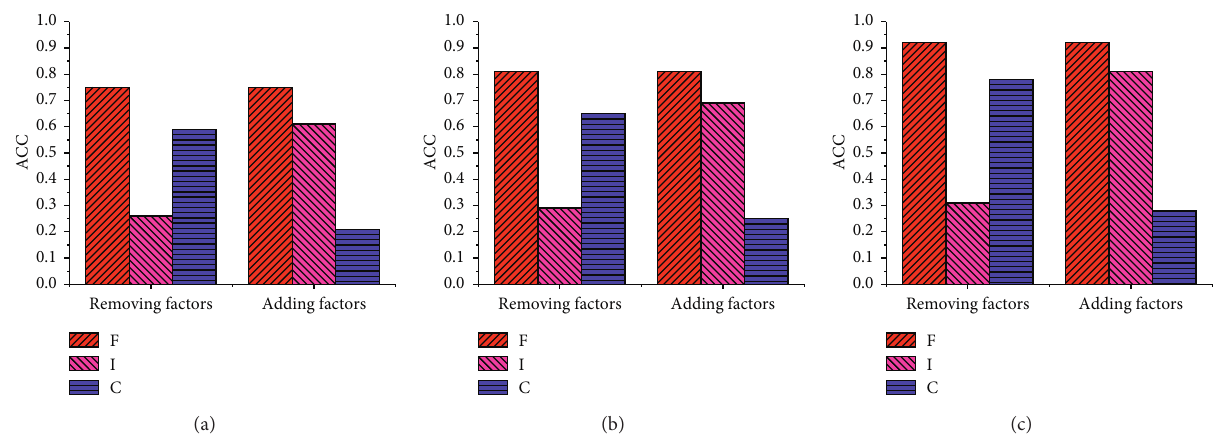
Figure 5: Factor contribution analysis. Four models trained with only or without the denoted factors. F , full feature set; I , intuitive factors; C , complex factors. (a) SVR. (b) GBDT. (c) XGBoost.